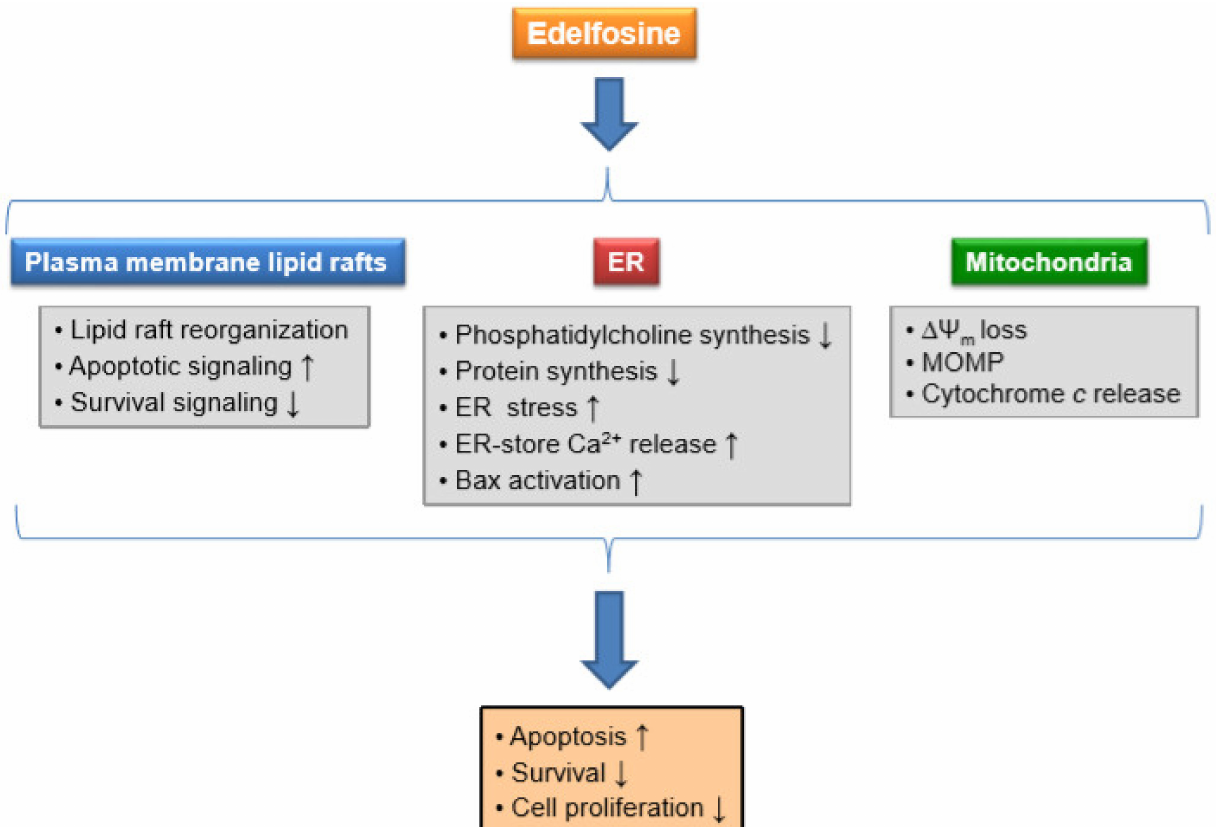
Figure 7. Major effects of edelfosine on lipid rafts, ER and mitochondria, and the subsequent consequences on cellular functions related to cell fate. This scheme represents several biochemical processes and cellular functions affected by edelfosine in cancer cells as discussed in the text and references